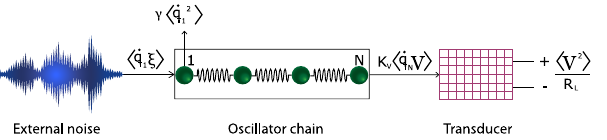
Figure 1. Sketch of an energy harvester based on a harmonic oscillator chain with one end in contact with the ambient noise and the other attached to the electrical transducer